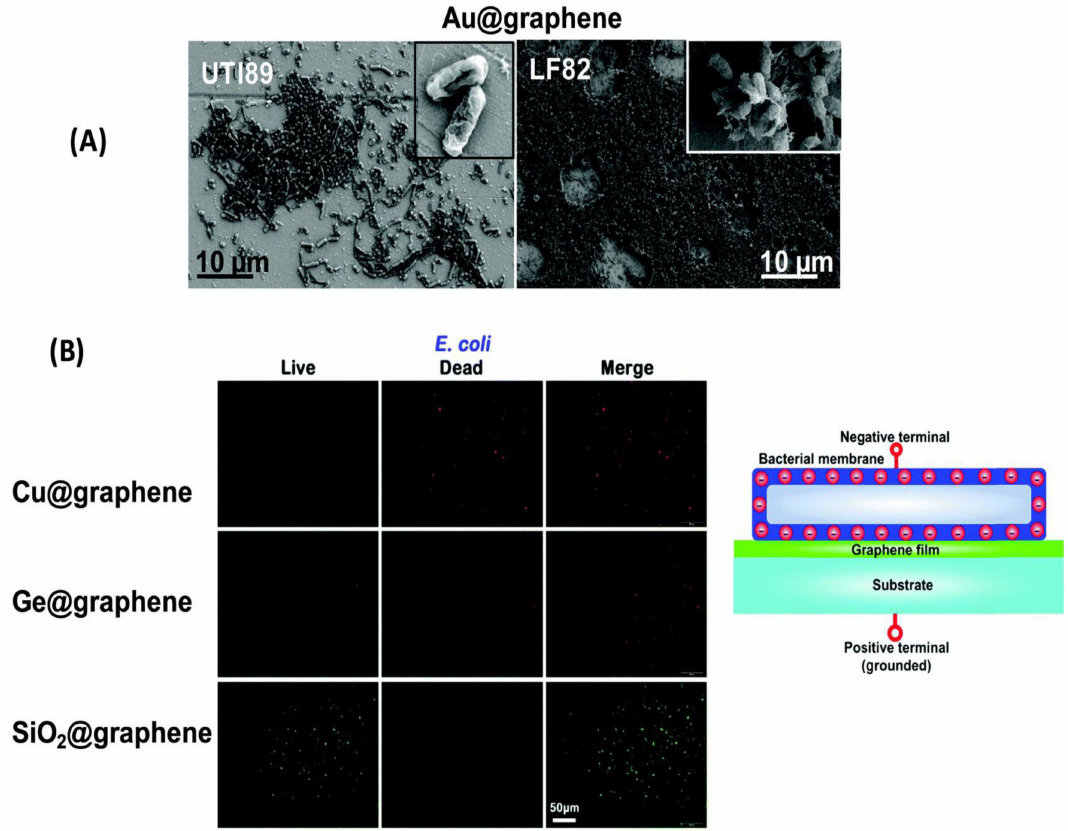
Figure 4. ( A ) SEM micrographs of E. coli UTI89 and LF82 on gold coated with CVD graphene; ( B ) fluorescence images showing the viability of bacteria after 24 h incubation over di ff erent interfaces (live bacteria are green, dead ones are red) and a schematic representation of the proposed mechanism. Reproduced from Ref. [42], with permission from Nature Research Publishing,